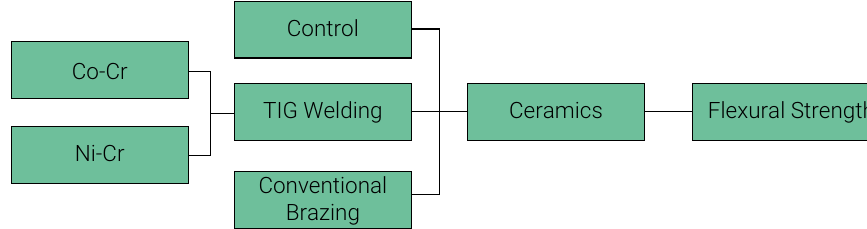
Figure 1. Flowchart of experimental